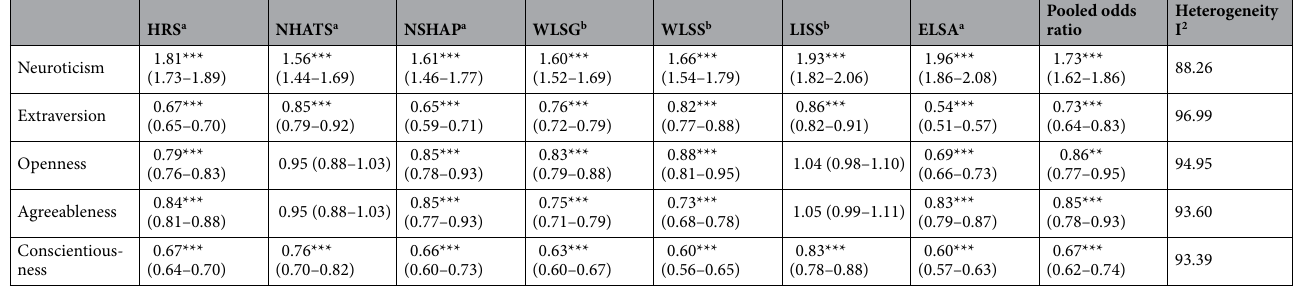
Table 2. Summary of logistic regression analysis predicting baseline fatigue from baseline personality traits. HRS: N = 12,364; NHATS: N = 2760; NSHAP: N = 2062; WLSG: N = 6590; WLSS: N = 3356; LISS: N = 5796; ELSA: N = 8078. a Adjusted for age, sex, education, and race. b Adjusted for age, sex, and education. * p < 0.05, ** p < 0.01, *** p <